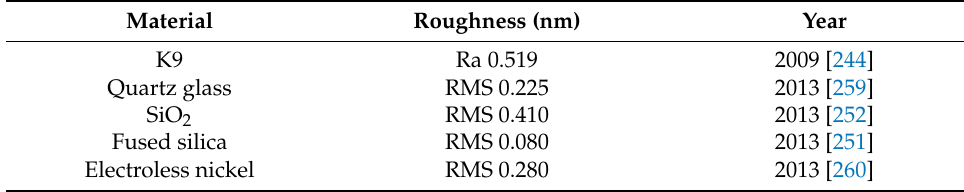
Table 10. The ultimate roughness achieved with FJP for different materials.